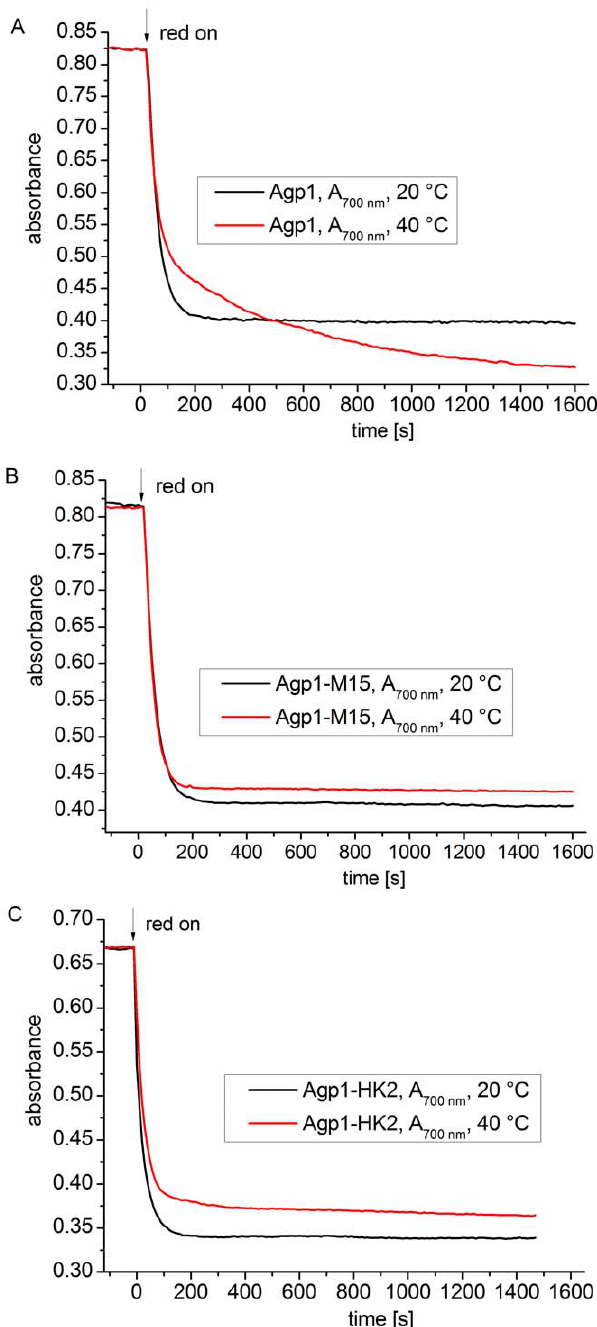
Figure 8. Photoconversion of Agp1, Agp1-M15, and Agp1-HK2 at 20 6 C and 40 6 C. Measurements were performed at 700 nm. At t=0, red light (655 nm, 20 m mol m 2 2 s 2 1 ) was switched on.